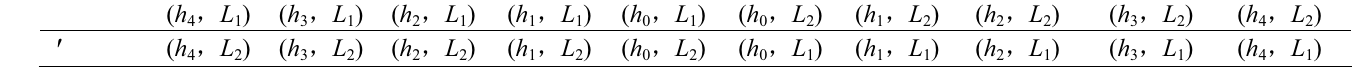
Table 1. Inverse operation of ten linguistic-valued credibility factors LIA